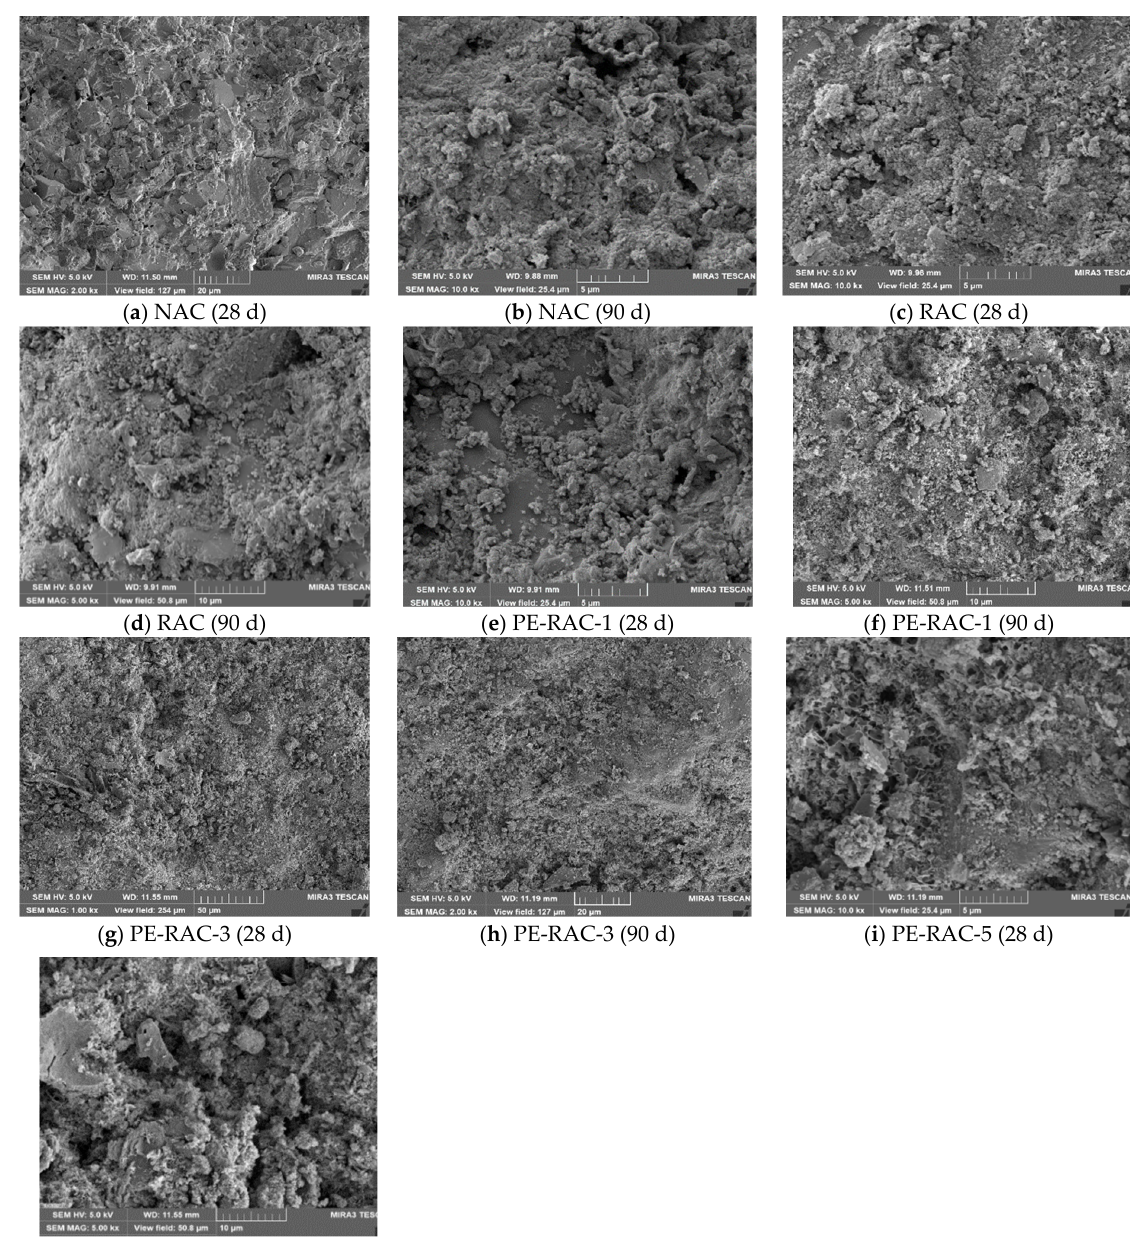
Figure 10. SEM scanning micromorphology of salt spray erosion in different